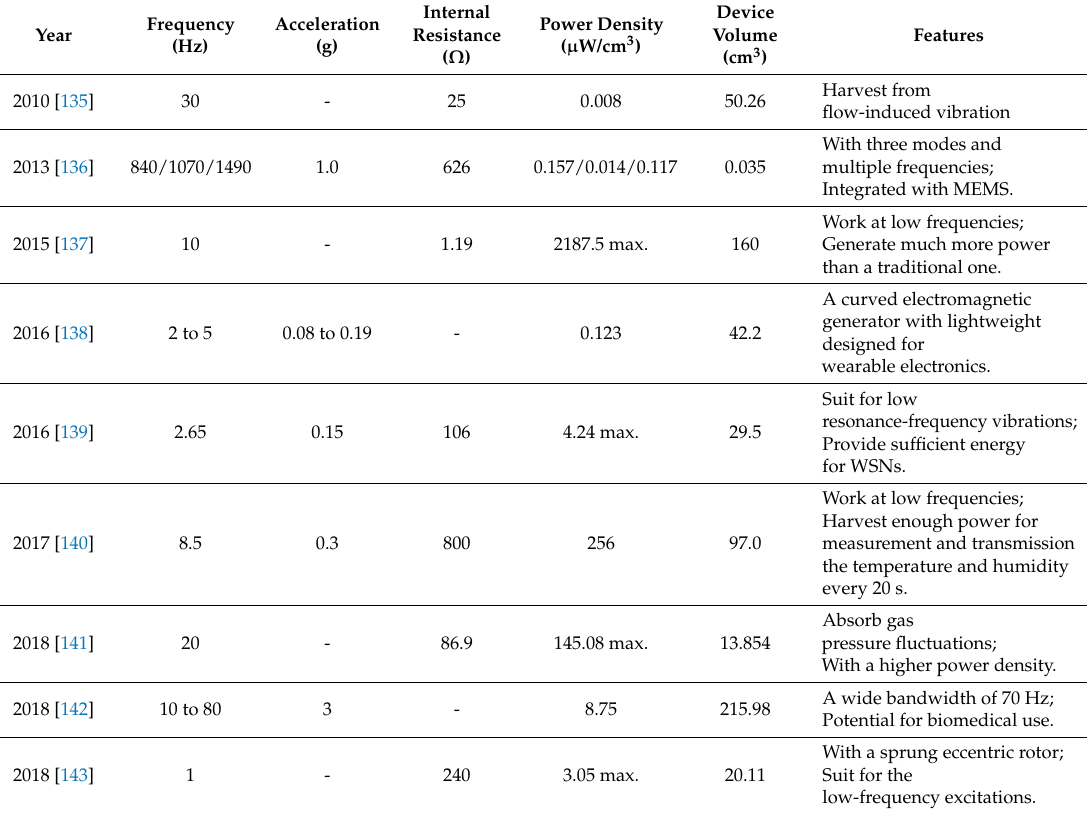
Table 5. Comparison of some electromagnetic generators found in the